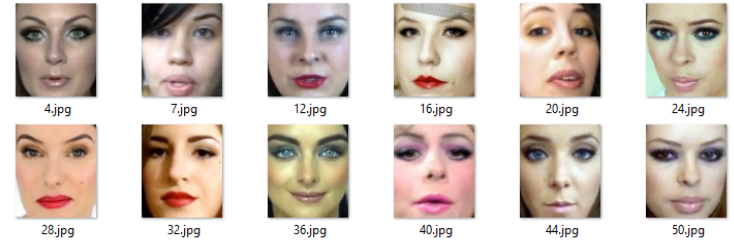
Figure 13. Testing images of 12